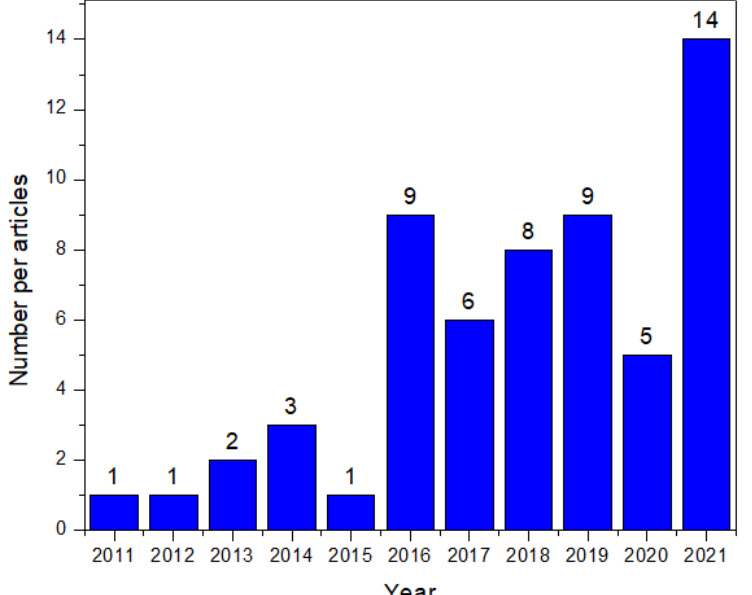
Figure 3. Number of final articles chosen and analysed per